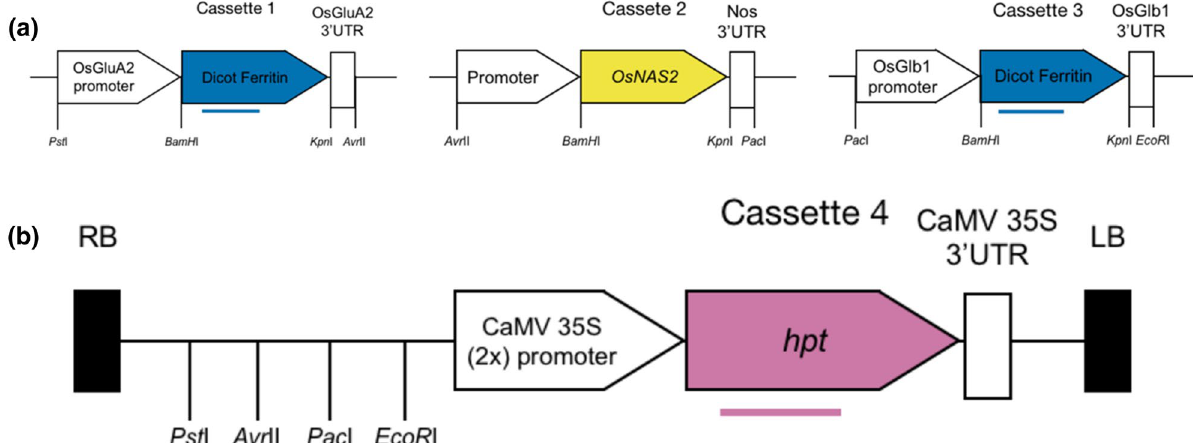
Figure 2. Schematic diagram of the T-DNA constructs prepared for rice transformation. ( a ) The dicot ferritin was either ApFer , PvFer or PsFer , whilst the promoter in cassette 2 is either the phloem specific OsTRXh promoter in combination or not with the maize ubiquitin intron, or the constitutive CaMV 35S promoter (single enhancer). The cassettes 1, 2 and 3 were initially assembled and cloned in TOPO vectors with the indicated overhangs. ( b ) The cassettes were introduced to the pCambia-based backbone by directional cloning after a series of digestions with respective enzymes and subsequent ligation reactions. The structure and orientation of the whole T-DNA region was confirmed by sequencing prior to rice transformation. RB and LB represent the right and left borders of the T-DNA, respectively; hpt : hygromycin phosphotransferase. The horizontal lines below dicot ferritins (blue) or the hpt (pink) genes represent the deduced hybridization position of the dioxigenin-labeled cDNA